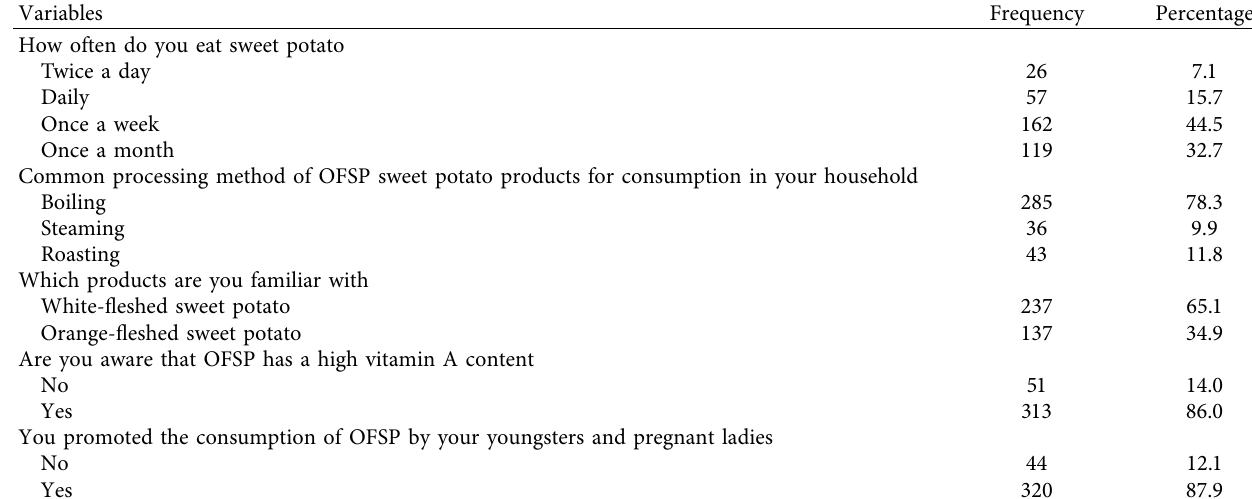
Table 7: Method of consumption and utilization of orange-fleshed sweet potato in the